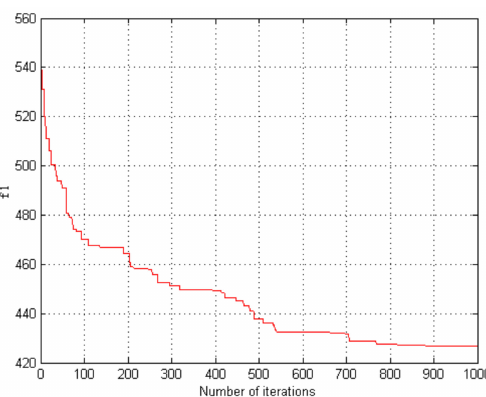
Figure 10. Curve of objective function 2.